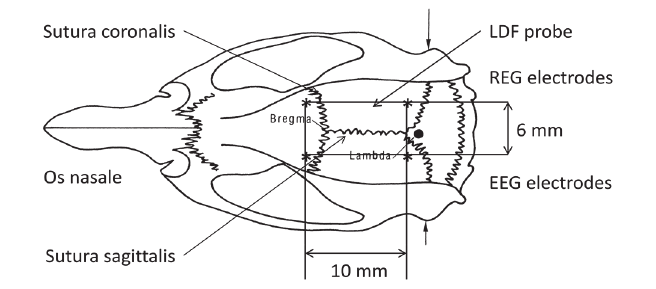
Fig. 1. Anatomical positions of REG, EEG electrodes and LDF probe are shown implanted in a rat skull (dorsal view). Standard orientation points in rat neurophysiology: bregma and lambda points and sutura between bones.